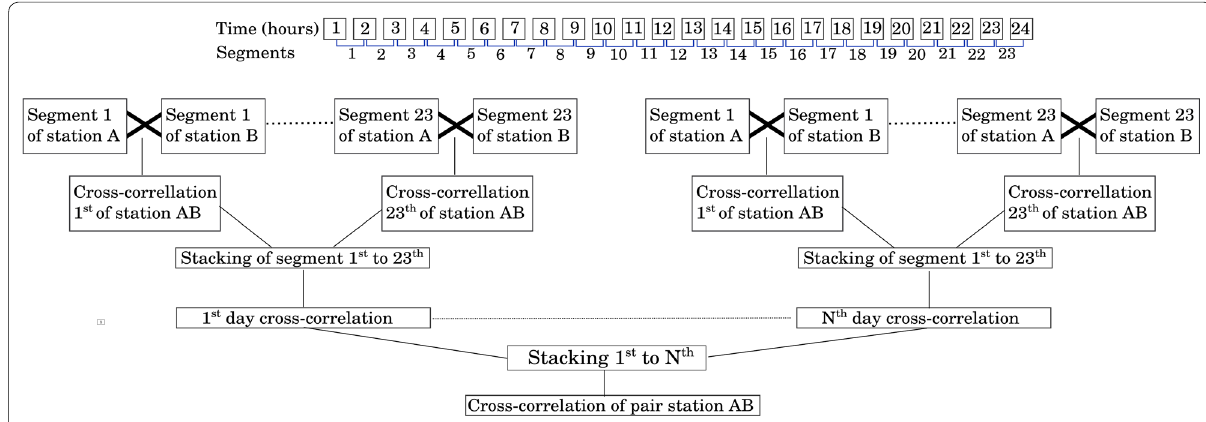
Fig. 2 Cross-correlation processing schemes in this research, for A and B pair